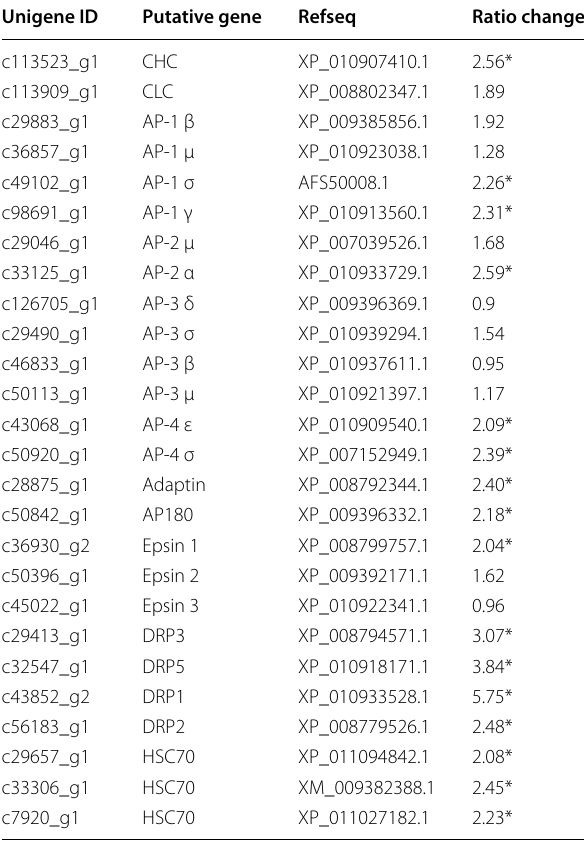
Table 2 The up- and down-regulated genes in protocorms of G. elata compared with